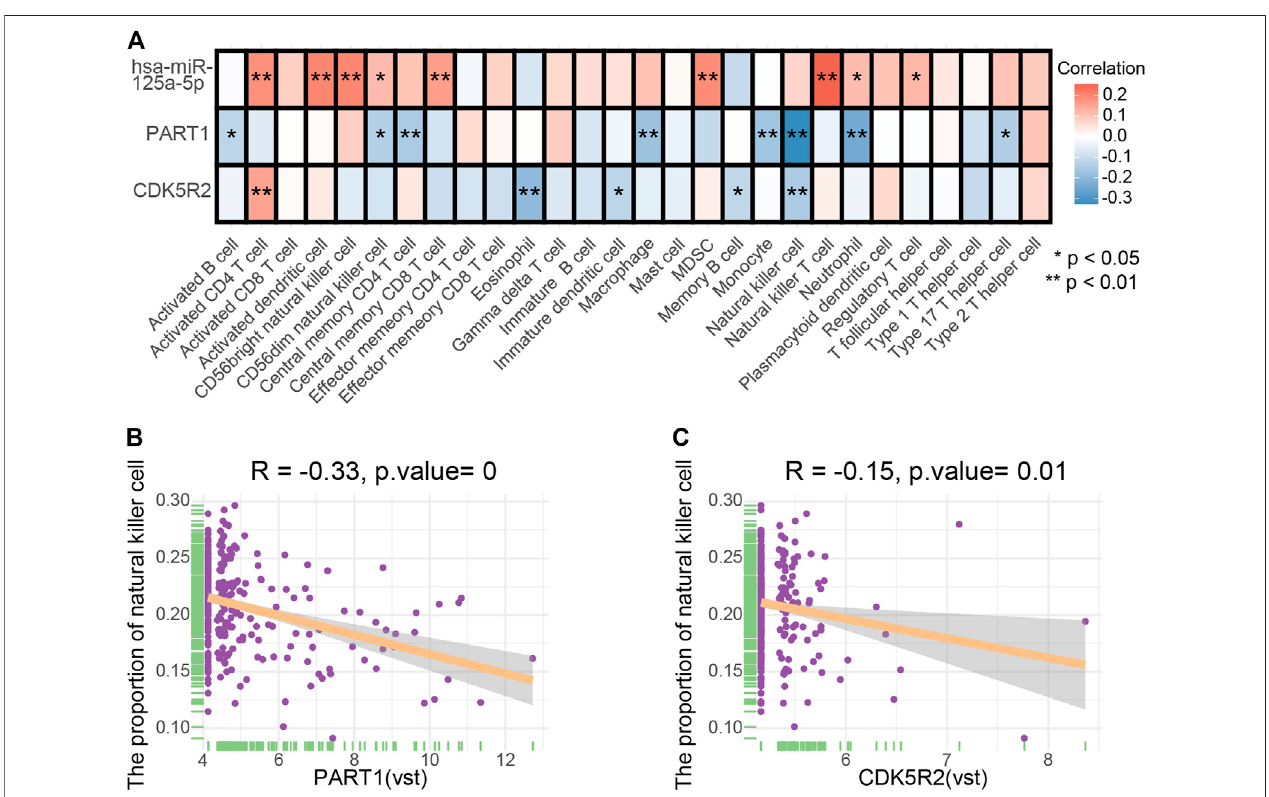
FIGURE 9 | (A) Correlation relationships between three ceRNA and 28 tumor-in fi ltrating immune cells. (B) Scatter plots illustrate the correlation between PART1 and NK cells ( p = 0, R = − 0.33). (C) Scatter plots illustrate the correlation between CDK5R2 and NK cells ( p = 0.01, R = −